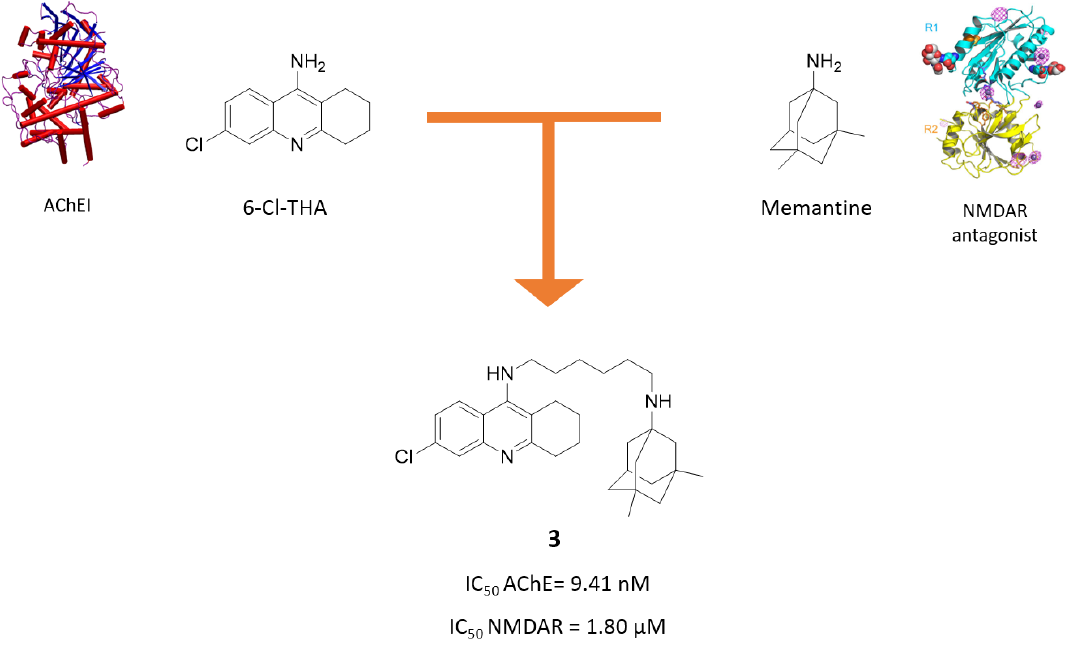
Figure 3. Drug design and biological activities of 6-chlorotacrine-memantine hybrid 3 .